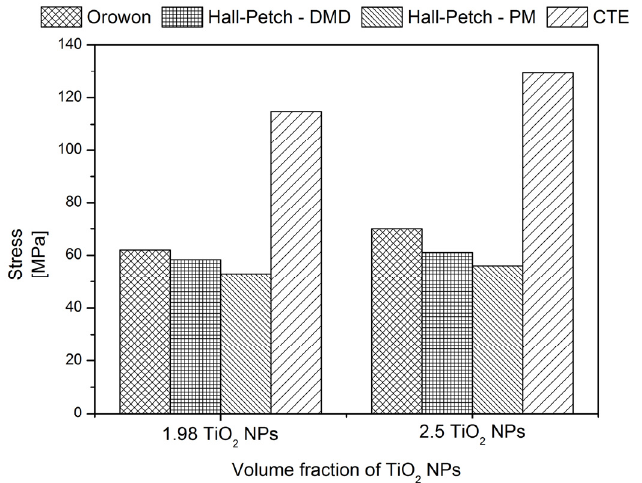
Figure 6. Individual contribution of strengthening mechanisms on the TYS of DMD and PM synthesized Mg/TiO 2